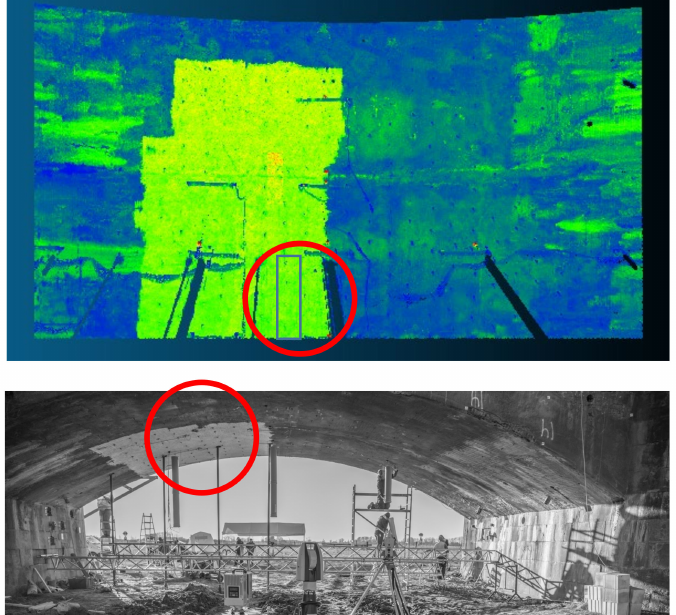
Figure 12. Top: visualization of the bridge for E00 using the software CloudCompare and localization of the patches of interest